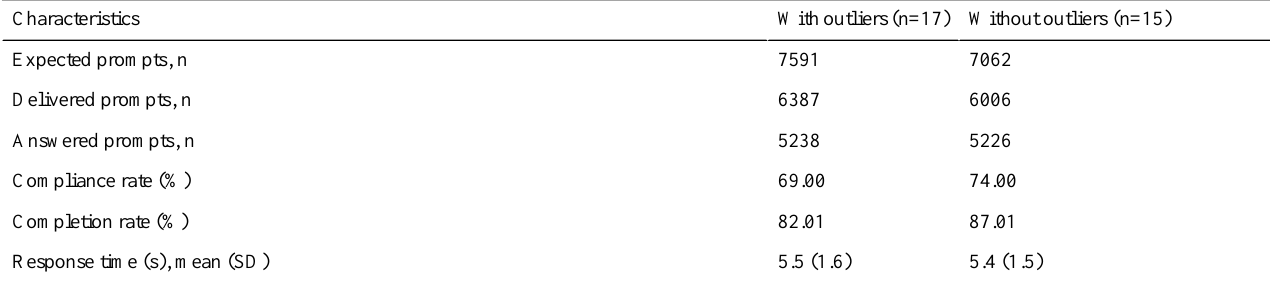
Without outliers (n=15)With outliers (n=17)Characteristics